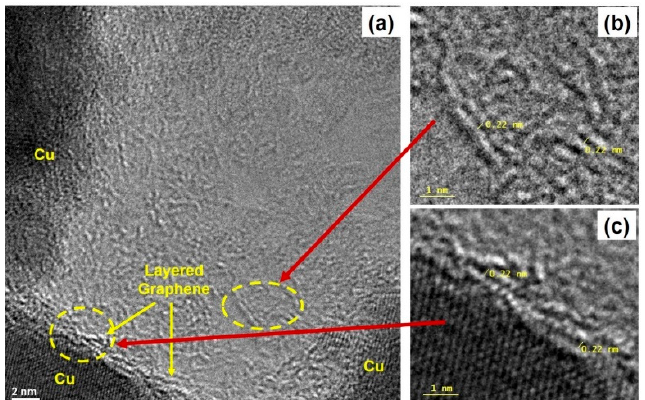
Figure A5. ( a ) High-resolution cross-sectional TEM image of the nanolayered carbon film in another nanoscale hole; ( b ) an enlarged view of the film inside the hole, showing nanolayered structures; ( c ) an enlarged view of the film on the surface of Cu substrate, showing nanolayered structures. Scale bar in ( a ): 2 nm; scale bar in ( b , c ): 1 nm.